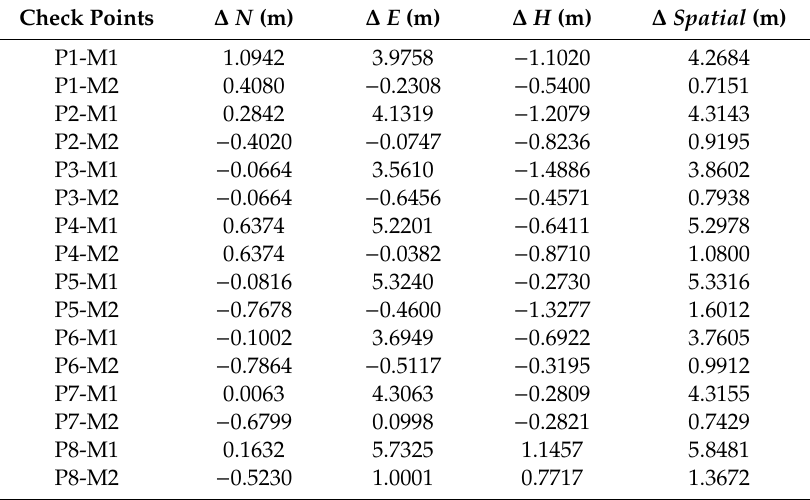
Table 2. The geolocation accuracy for the eight corner points.